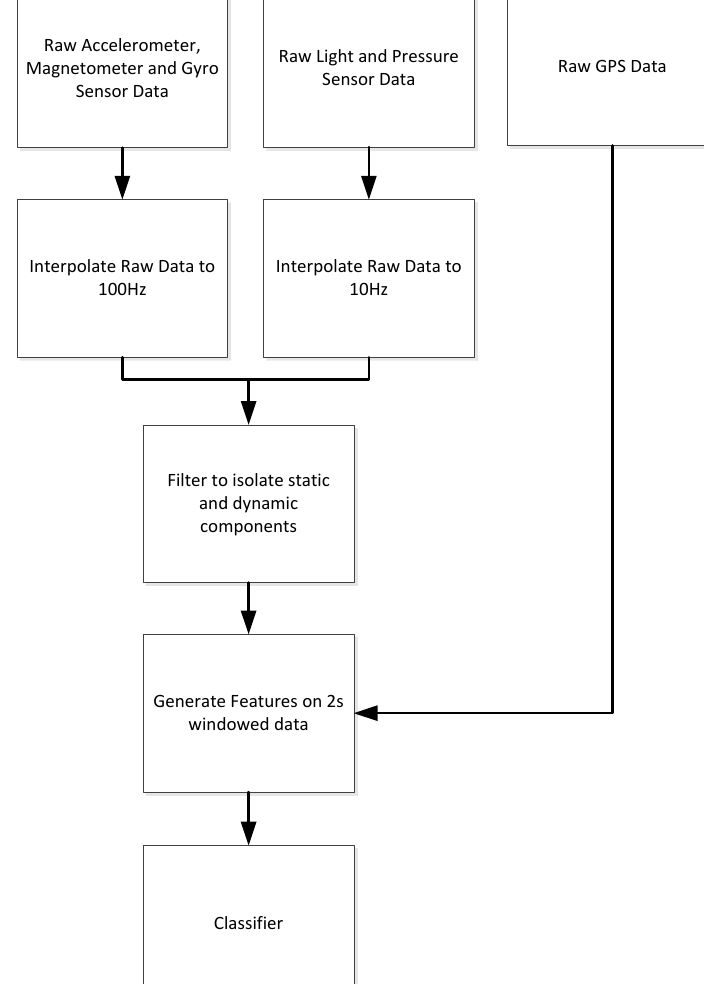
Figure 2. Signal processing flow